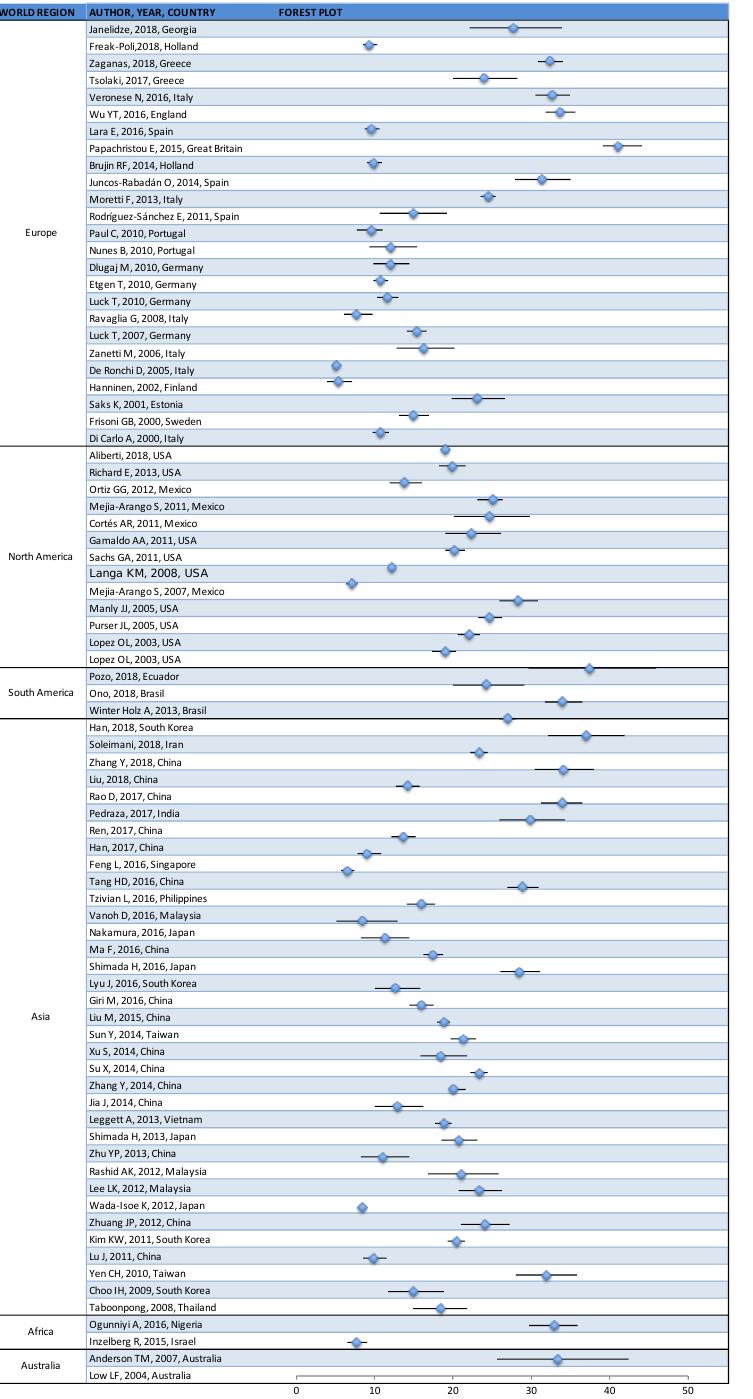
Figure 2. Prevalence of cognitive impairment reported by published papers, which are grouped by world region (95% confidence intervals were obtained from papers or calculated from the data presented).